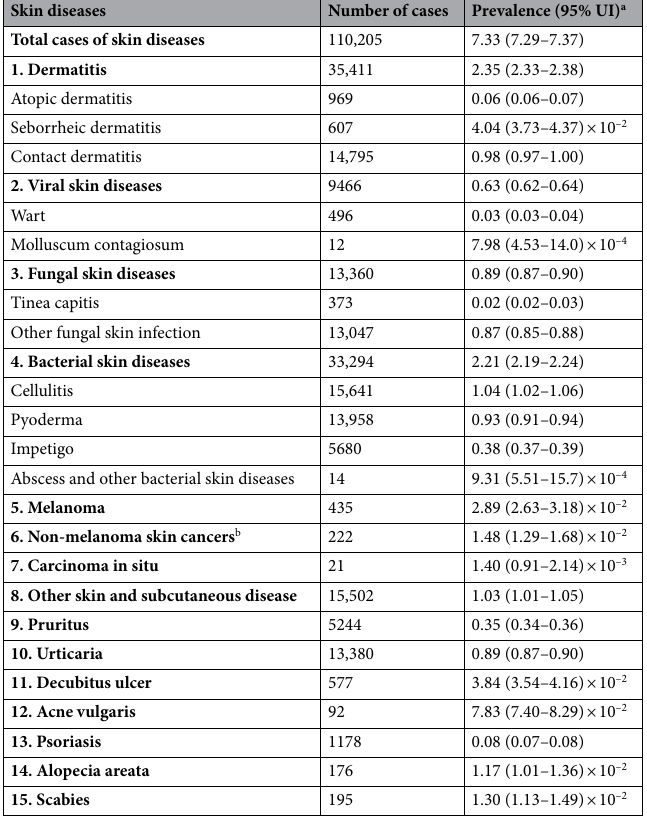
Table 1. Numbers and prevalences of 15 skin diseases diagnosed and treated in Ubonratchathani’s healthcare services in 2018. a Prevalence is presented in percent and 95%UI calculated using Bayesian bootstrap